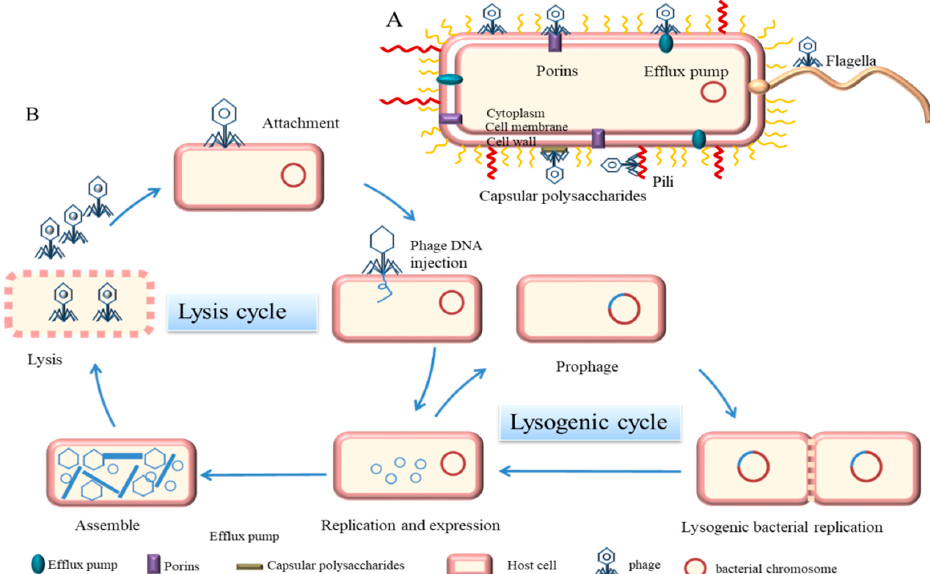
Figure 1. Mechanism of phage infestation of bacteria. ( A ) Receptors for phage adsorption on bacteria (purple represents porins, blue represents efflux pumps, yellow represents flagella, red represents pili, and gray represents capsular polysaccharide) ( B ) Described five phases of a phage lytic cycle and a lysogenic cycle.